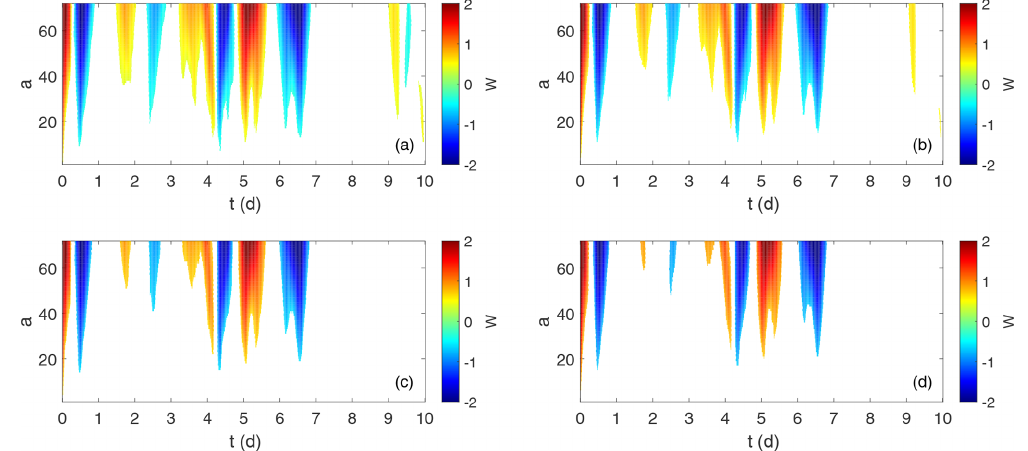
Figure 4. The CWT coefficients W ( a,b ) of the normalised wind power discriminated from the distribution of W ∗